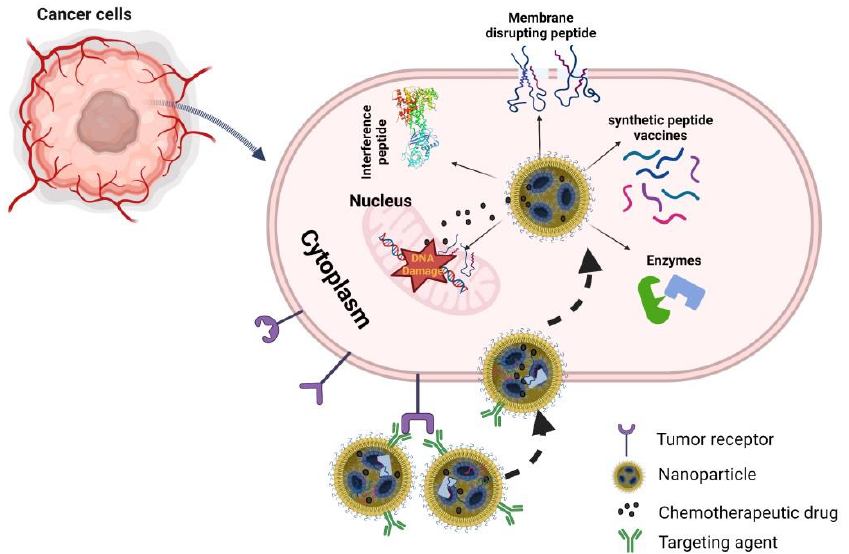
was created using Figure 3. Summary of different types of peptides that nanoparticles can deliver to cancer cells. Figure was created using biorender.com.